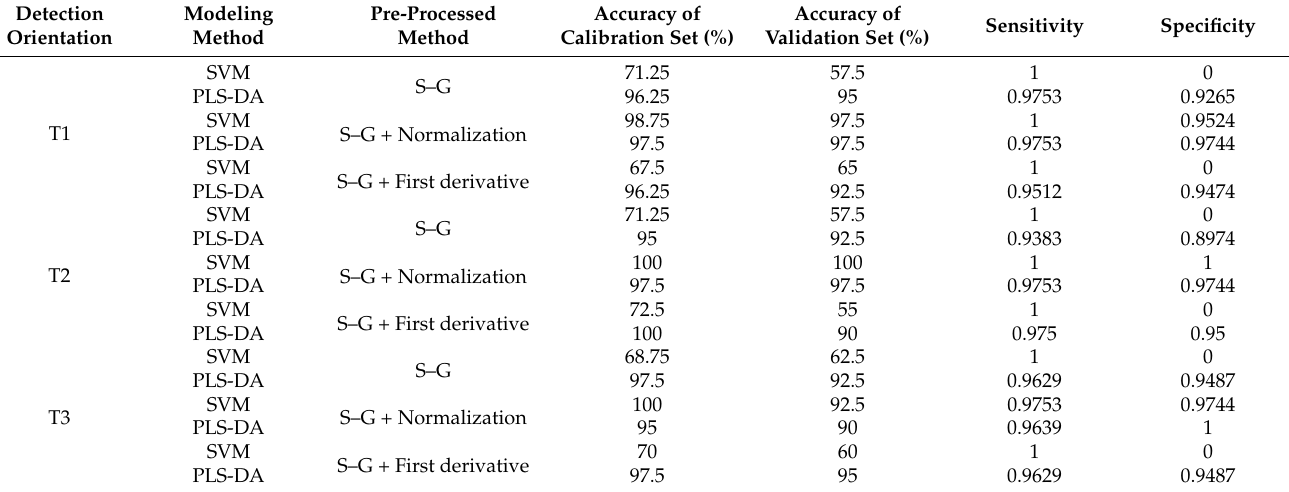
Table 2. The classification performance of the SVM model and the PLS-DA model obtained by using different preprocessing methods in the T1, T2, and T3 orientations (motion